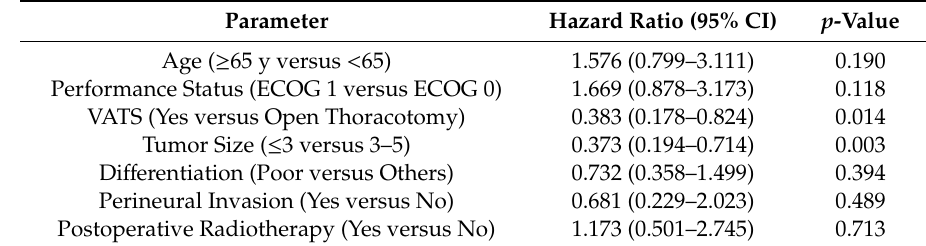
Table 3. Multivariate analysis of factors associated with overall